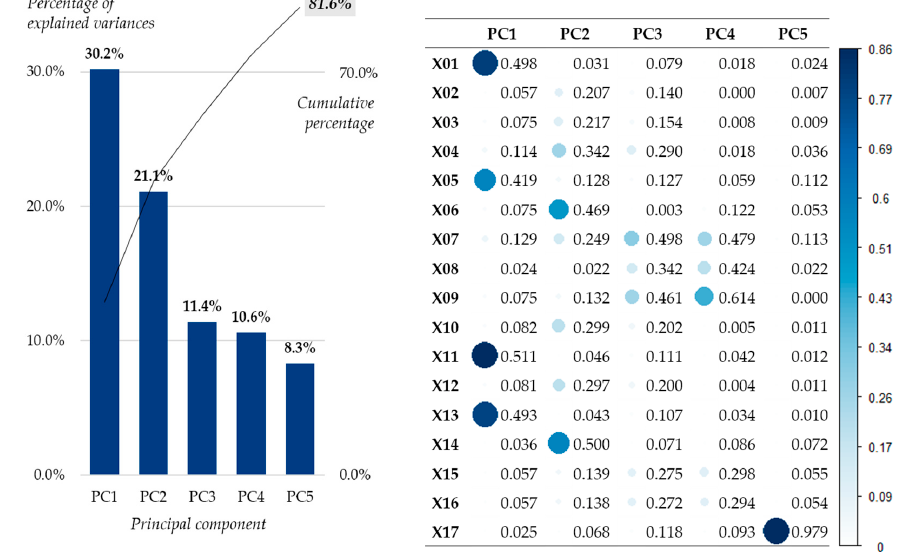
Figure 5. Scree plot: plot of eigenvalues ordered from PC1 to PC5 and contributions of all variables to PCs.